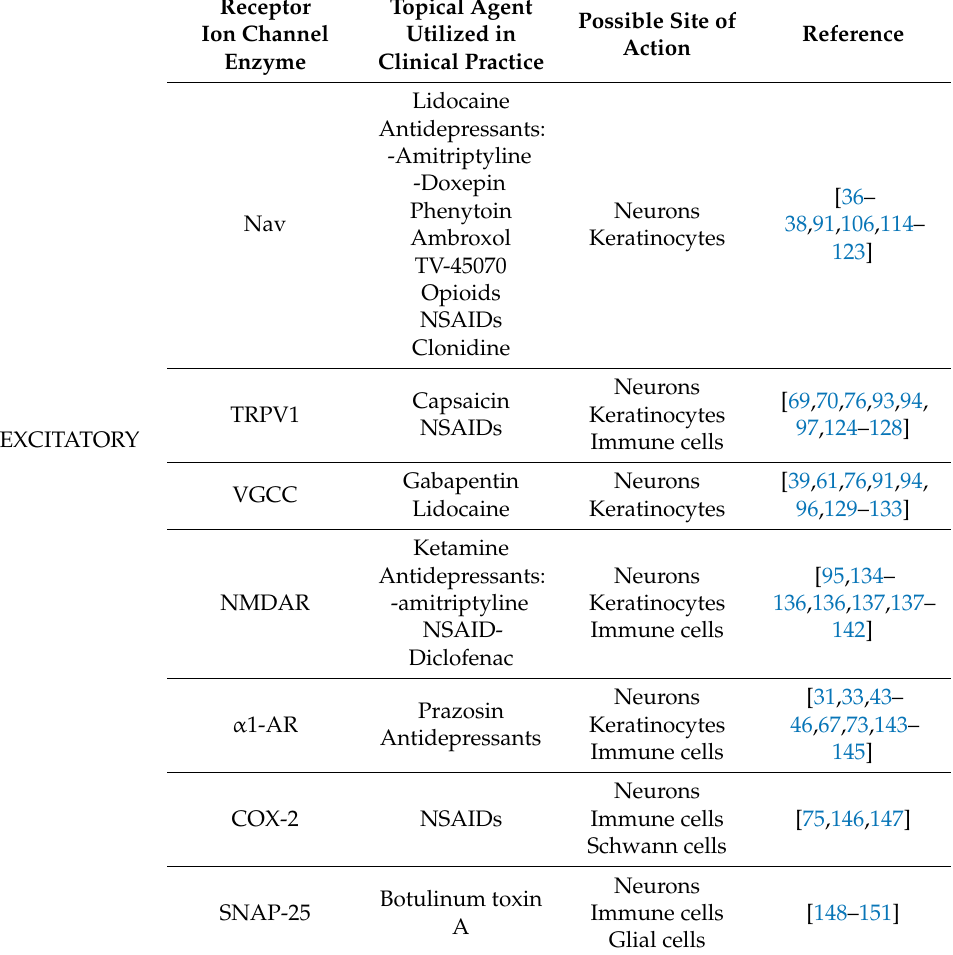
Table 1. Receptors, ion channels, enzymes with excitatory mode of action, involved in generation and maintenance of NP, potentially targeted by topically administered treatments. Possible site of action of topical agents, addressing given molecular target. Abbreviations: Nav—voltage-gated